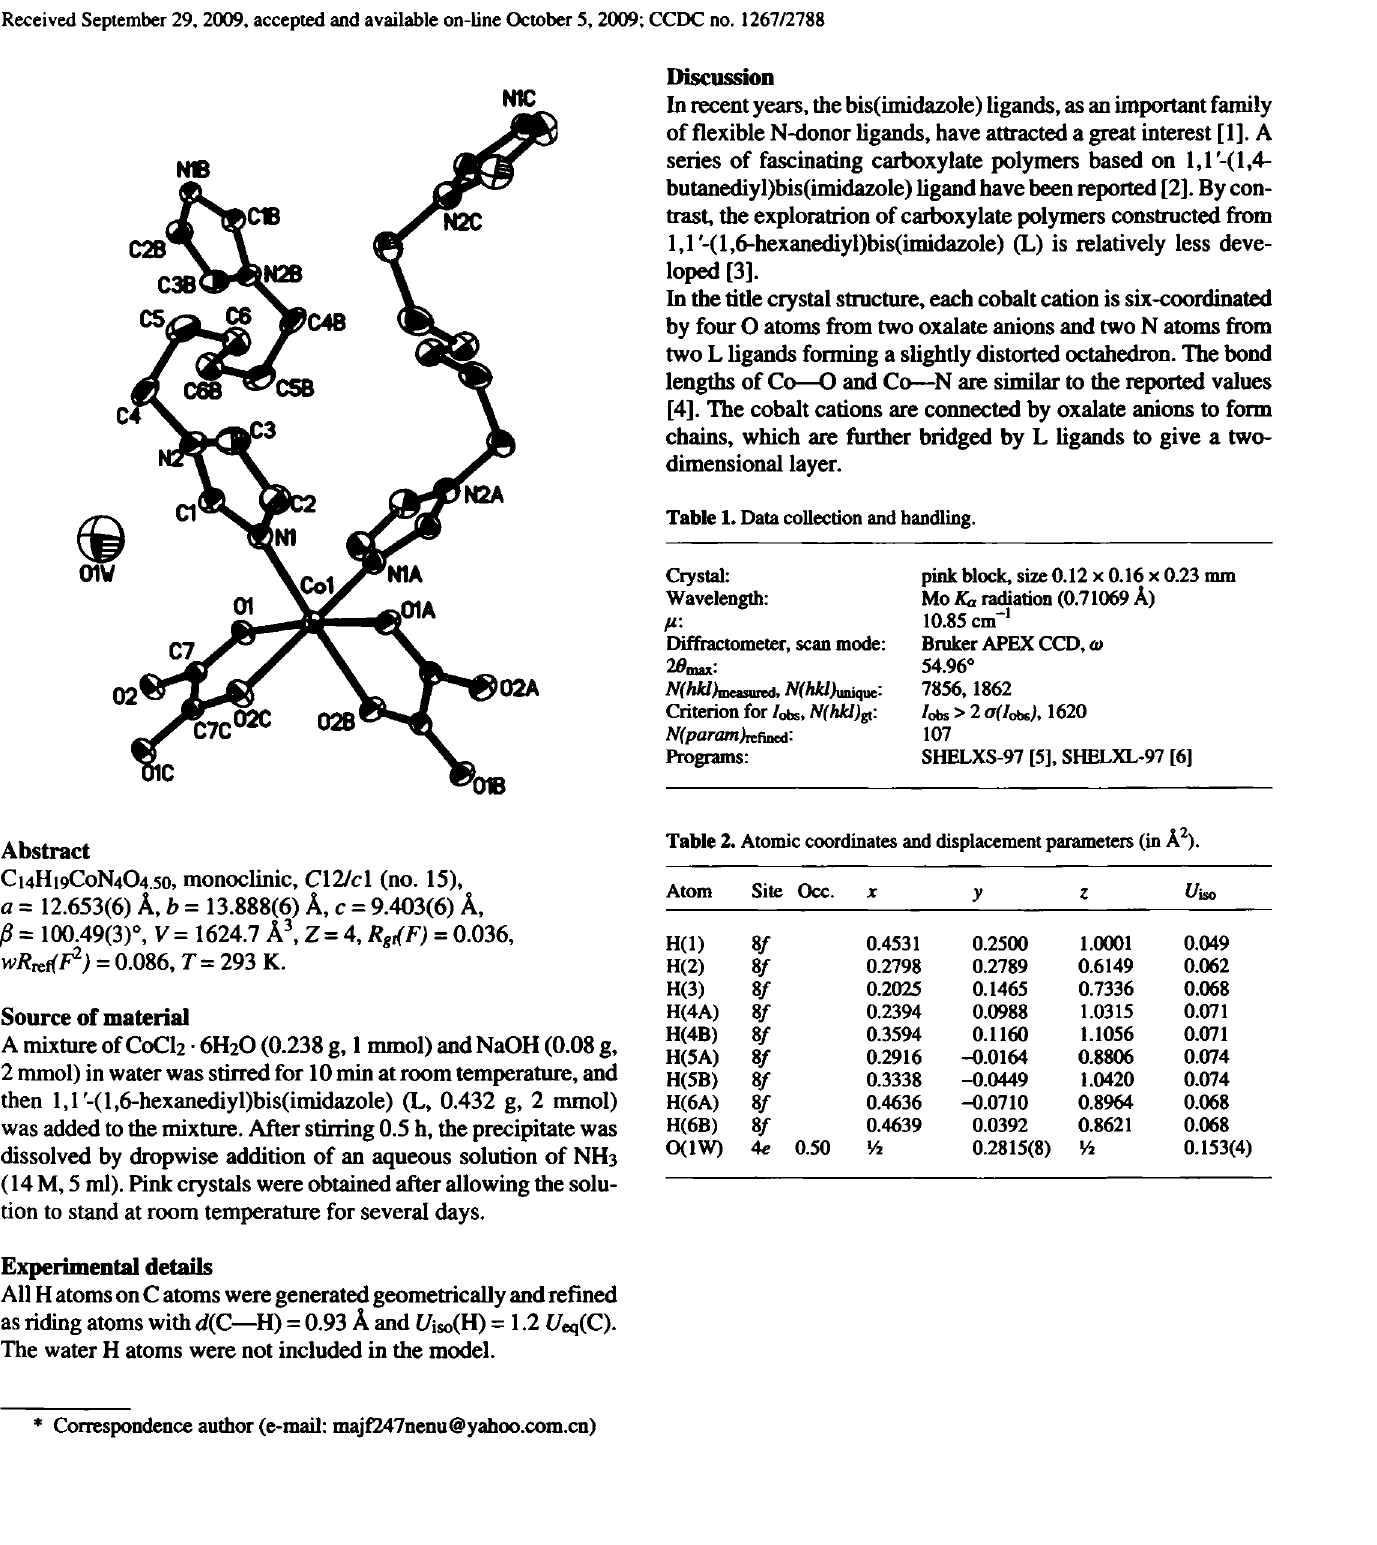
Table 1. Data collection and handling.